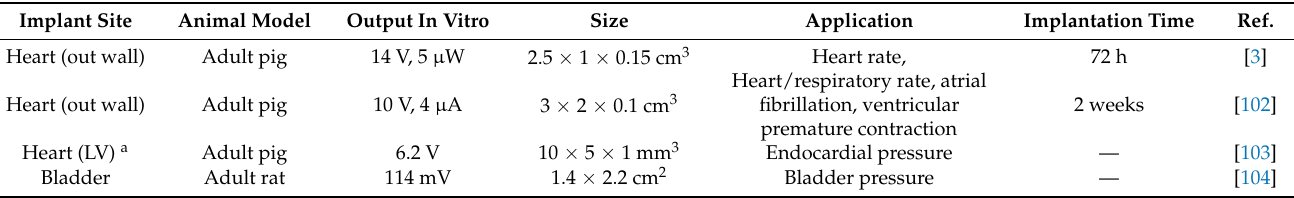
Table 1. The summary of the self-powered